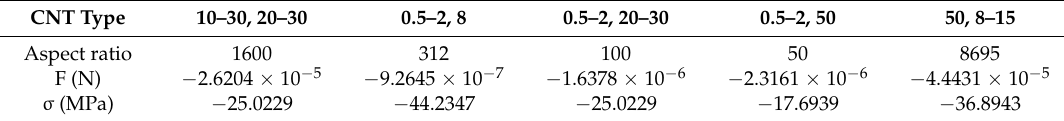
Table 4. Aspect ratios, van der Waals forces, and cohesive force of carbon